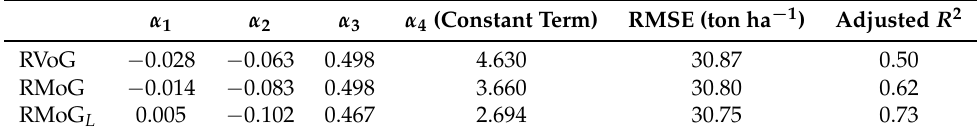
Table 2. Coefficients of the fitted polynomial model (within a 95% confidence